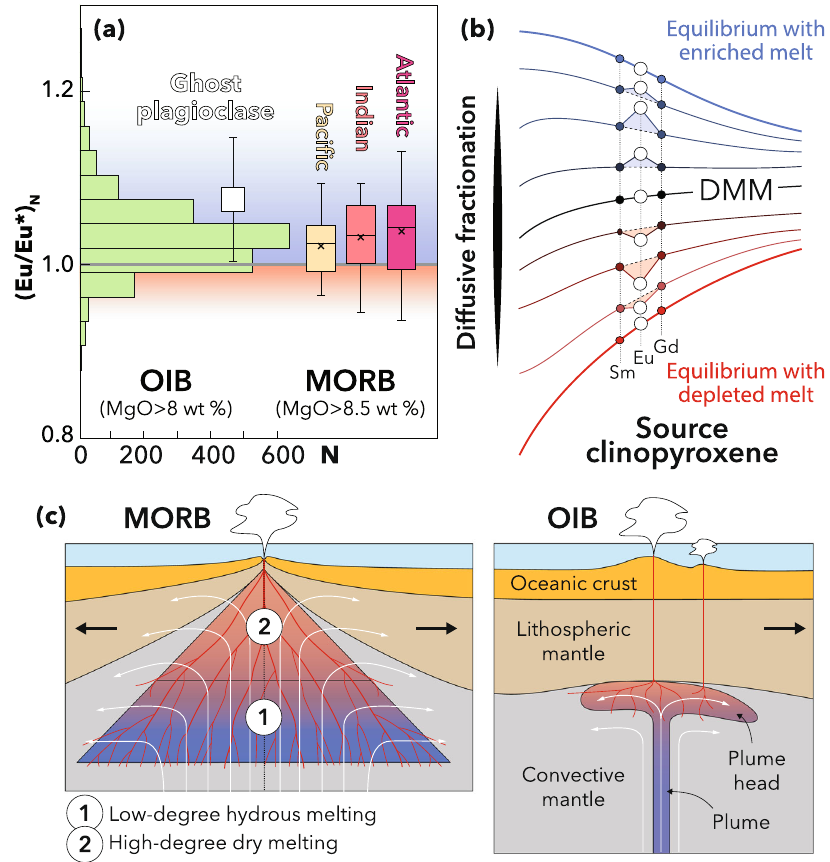
Fig.5|DevelopmentofkineticEuanomaliesinthemantlesourceofMORBand OIB. a Global distribution of Eu anomalies in MORB and OIB glasses compared to Hawaiian melt inclusions with a ghost plagioclase signature. b Conceptual repre- sentation of the development of positive and negative Eu anomalies by diffusive fractionation in bulk clinopyroxene depending on the melt compositions. Positive Eu anomalies can be kinetically produced in clinopyroxene upon interaction with enriched melts (in blue), as documented by the Oran clinopyroxene data. Dis- equilibrium melting can also produce (or enhance) positive Eu anomalies in the